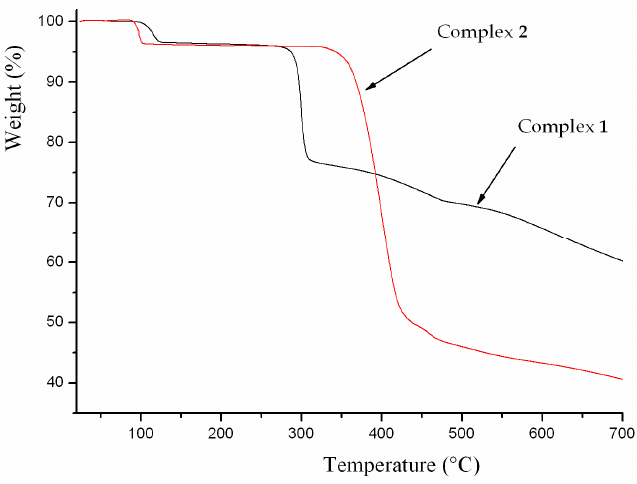
Crystals 2017 , 7 , 228 Figure 7. Thermal analysis curve of the complexes 1 and 2 . Figure 7. Thermal analysis curve of the complexes 1 and 2 .